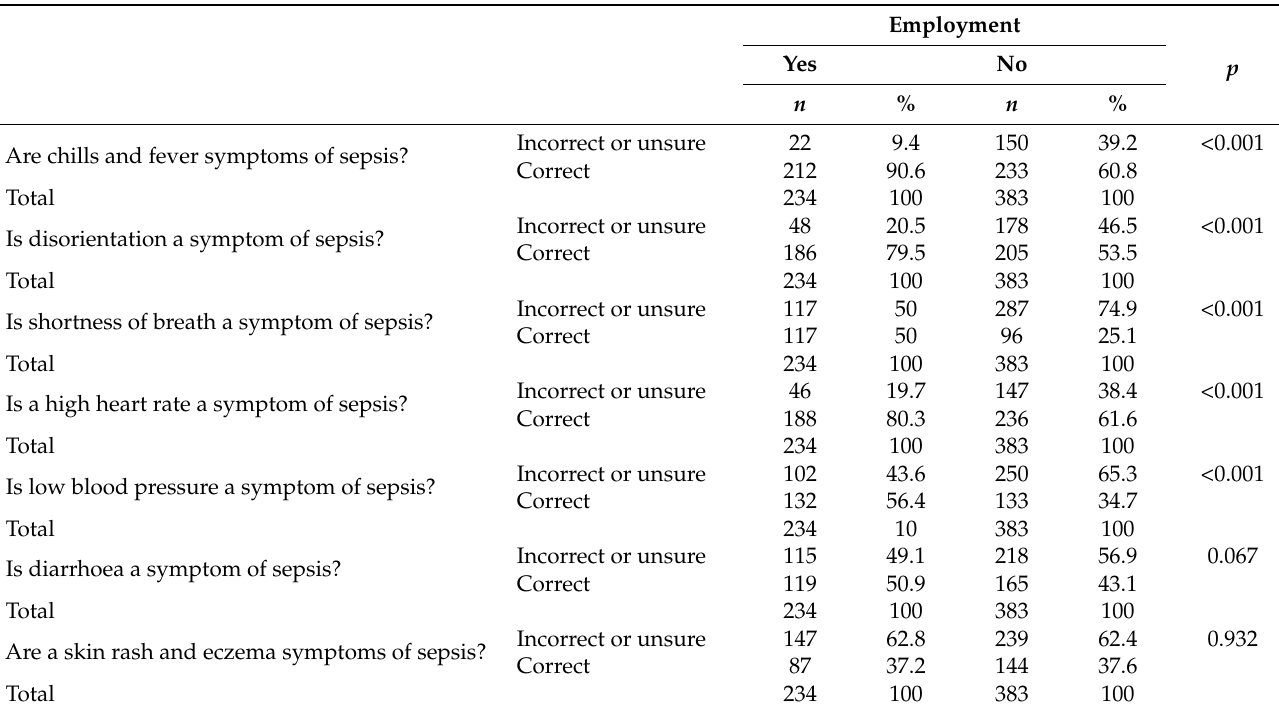
Table 5. Percentage and number of students with correct answers to “Knowledge of the symptoms of sepsis” according to